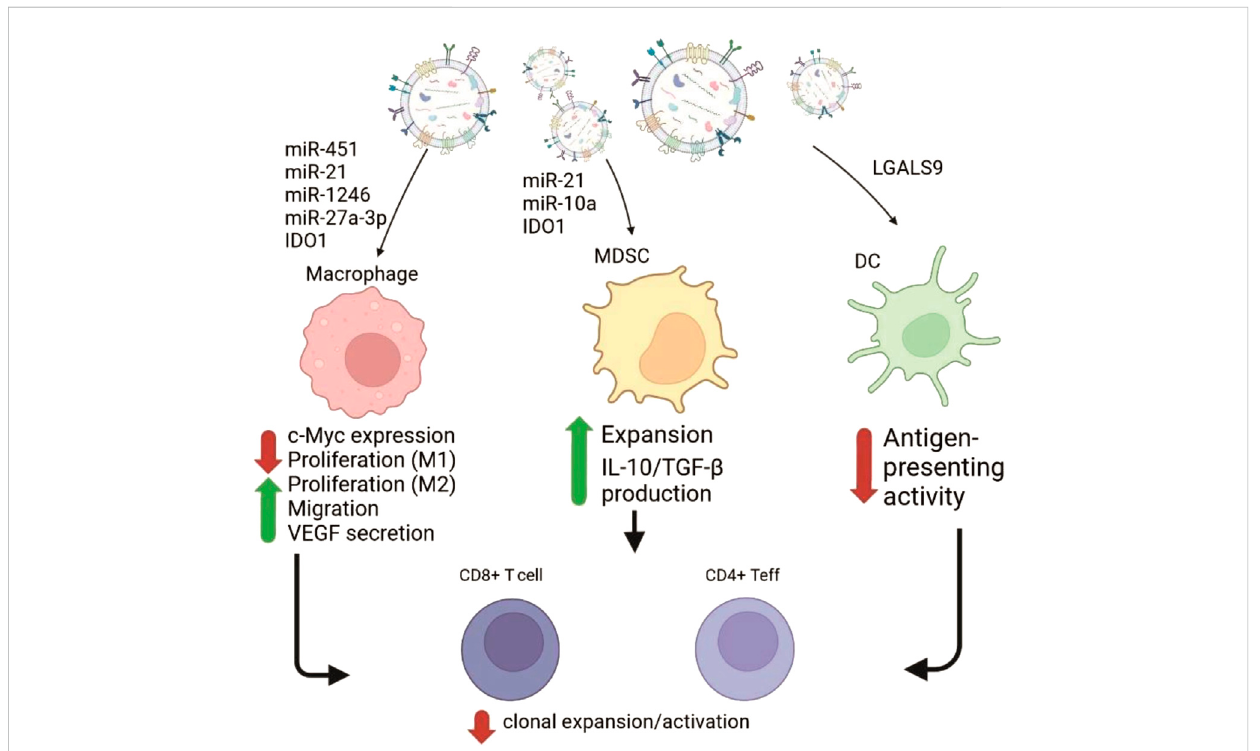
FIGURE 2 Schematic representation of GBM-EVs effects on the myeloid immune cells mediated by transfer of the cargo molecules (mostly RNAs). GBM-EVs (on the top) fuse with or get phagocytosed by macrophages, myeloid-derived suppressor cells (MDSC) and dendritic cells (DC) causing changes in phenotype of recipient cells. Cargo molecules participating inreprogramming and resulting phenotypicresponses (Cheryl etal., 2013; Mooij et al., 2020; Liangetal.,2019;Jungetal.,2022)areshown asred(negative effect)orgreen (positiveeffect)arrows withsupporting text.Subsequentin fl uenceof changes in myeloidcells negatively affect anti-tumor immunity by suppressing functions of CD4 + effector cells and CD8 + cytotoxic lymphocytes (on the